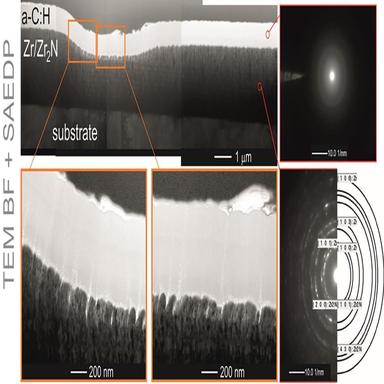
A cross-section image showing pitting corrosion as a consequence of the anodic dissolution of the Zr/Zr2N (1:4 ratio) multilayer coating with a-C:H top-layer coating performed by TEM.